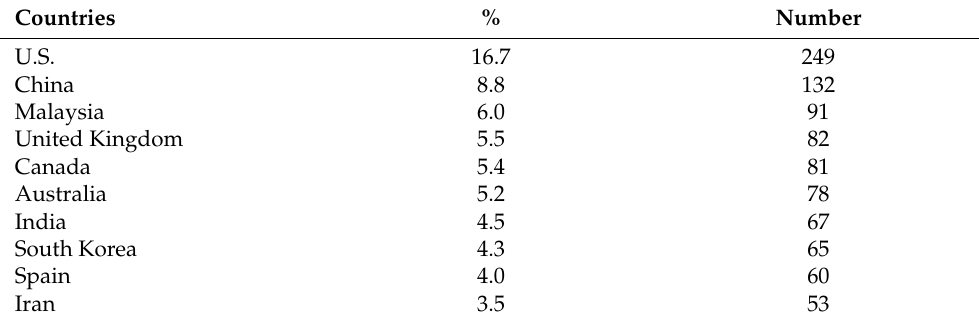
Table 7. Number of publications by country.